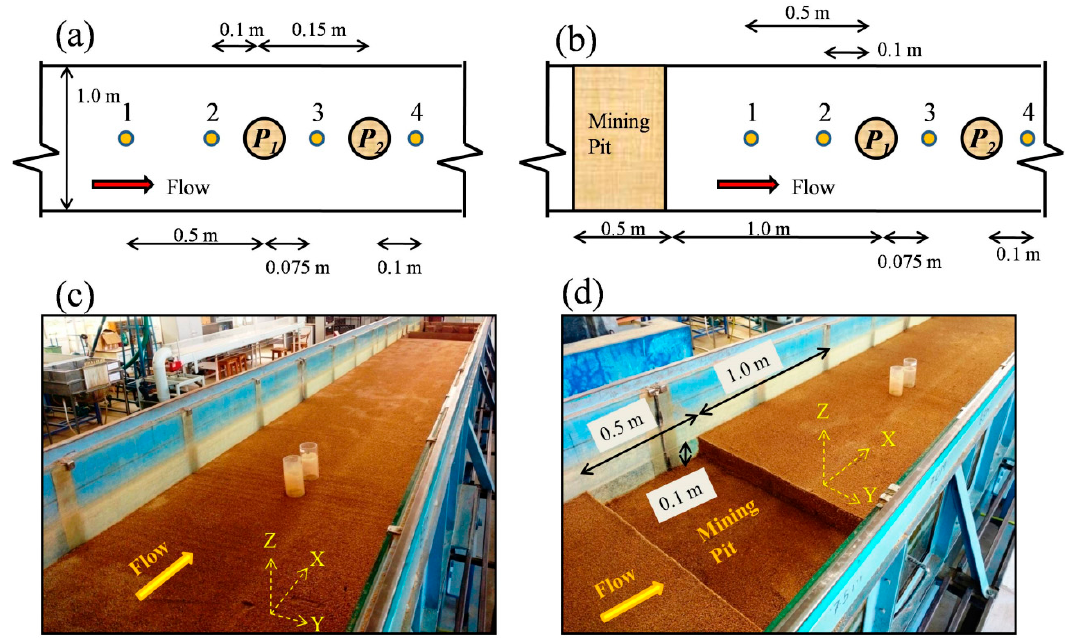
Figure 2. Schematic plan view of data recording locations for: ( a ) Case A, no pit; ( b ) Case B, with pit. Snapshots of experimental cases: ( c ) Case 1, no pit; ( d ) Case 2, with pit.